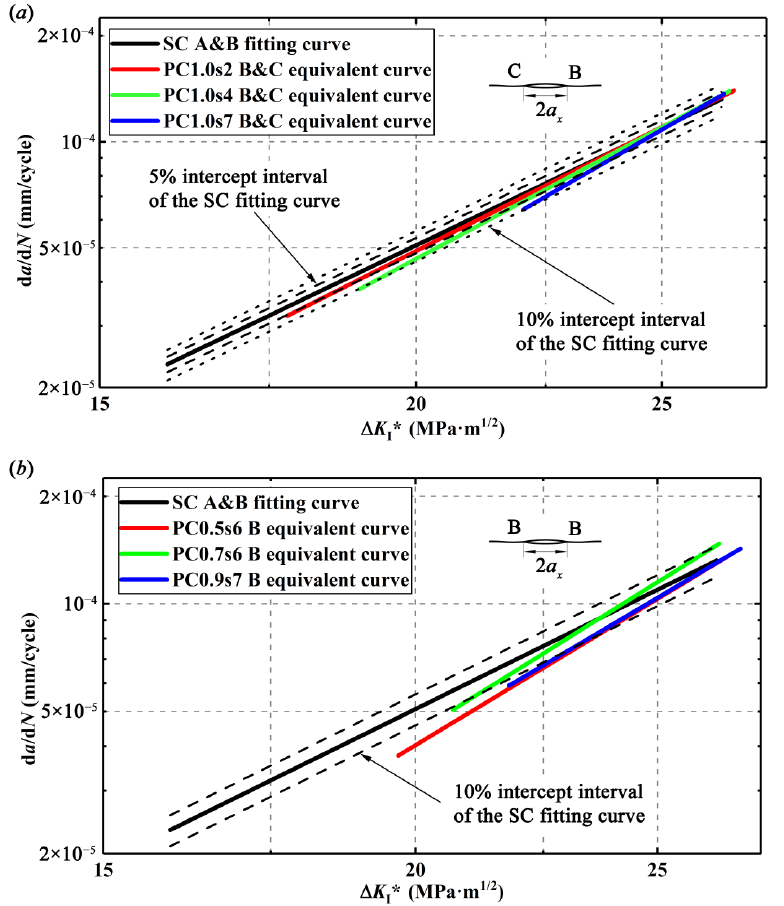
Figure 13. d a / d N vs. ∆ K I* for di ff erent specimens: ( a ) single crack and length-equivalent single crack from double equal cracks and ( b ) single crack and length-equivalent single crack from double unequal